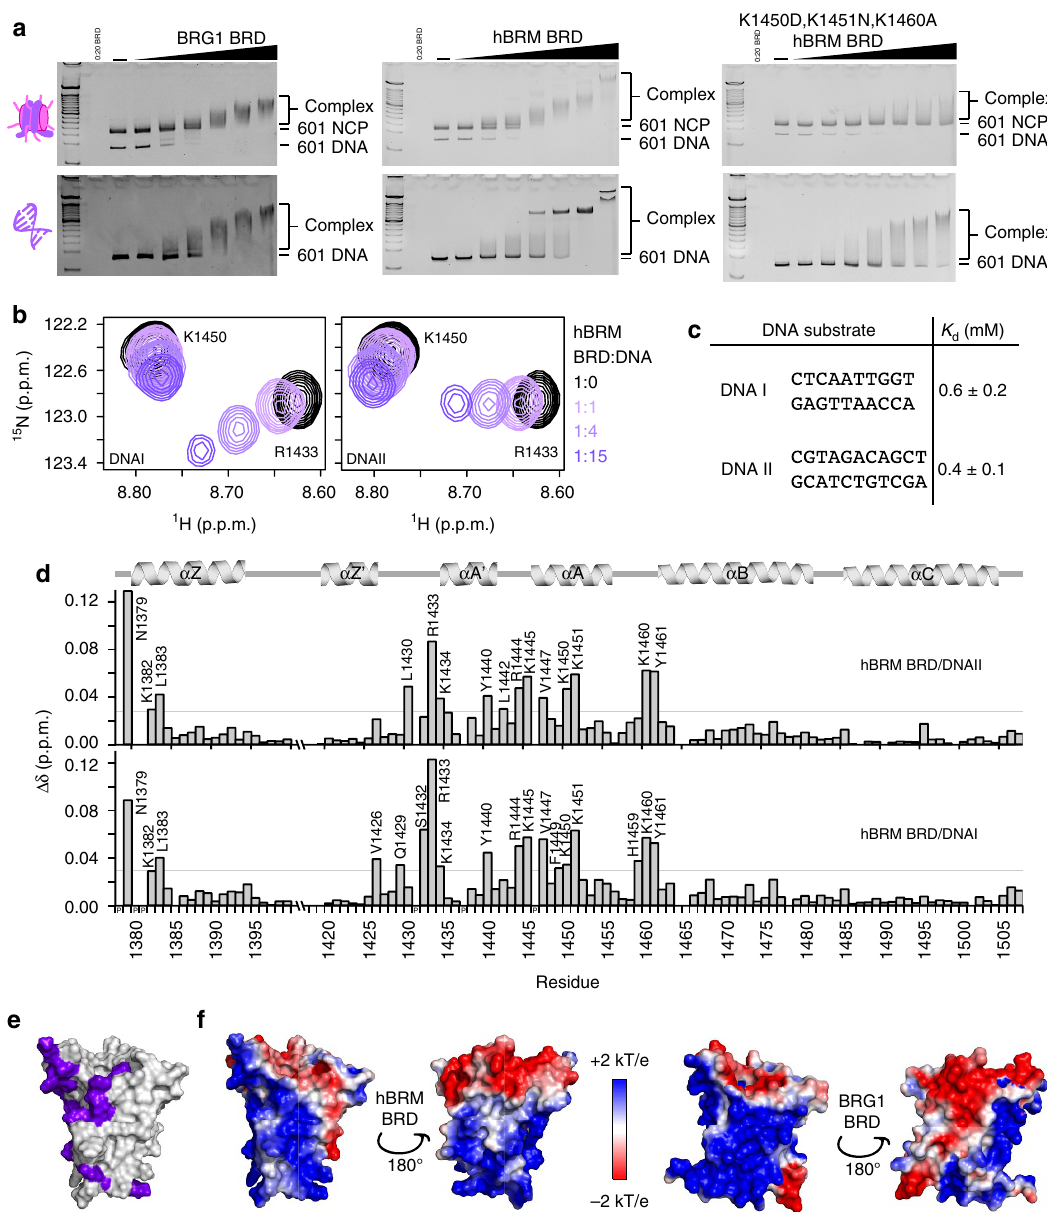
Figure 3 | The hBRM and BRG1 BRDs interact with linear and nucleosomal DNA through a surface basic patch. ( a ) EMSAs carried out with BRG1 (left), hBRM (centre), or K1450D,K1451N,K1460A mutant hBRM (right) BRDs and either 601 NCP (top) or free 601 DNA (bottom). Gels were run with a 100bp DNA ladder in the far left lane and stained with ethidium bromide for visualization. ( b ) Overlay of 1 H- 15 N HSQC spectra of 15 N-hBRM BRD upon titration of DNAI or DNAII. The selected region displays resonances for R1433 and K1450, and spectra are colour coded according to protein:DNA molar ratio as shown in the legend. DNA titrations were collected at protein:DNA molar ratios of 1:0, 1:0.25, 1:0.5, 1:1, 1:2, 1:4, 1:8 and 1:15 (additionally 1:18 for DNAII). For clarity, only 4 points are displayed. ( c ) Table of dissociation constants determined from NMR titrations with 15 N-hBRM BRD. K d values are fit to a single-site binding model under ligand-depleted conditions using 8–9 titration points. Shown are the averages over individual residues with significant CSPs (12–19 in total) and associated standard deviation. ( d ) Corresponding normalized CSPs are plotted as a function of residue upon titration of DNAI or DNAII for the protein:DNA molar ratio of 1:15. The secondary structure of the BRD is denoted above the plots, and residues that are perturbed greater than the average plus two standard deviations after trimming off the top 10% of CSPs are labelled. A grey line marks this level of significance for each titration. ( e ) A surface representation of the hBRM BRD structure (PDB ID 2DAT) with residues that are significantly perturbed upon binding to DNAI are coloured in purple. ( f ) APBS-computed surface electrostatics for hBRM and BRG1 BRDs (PDB IDs 2DAT and